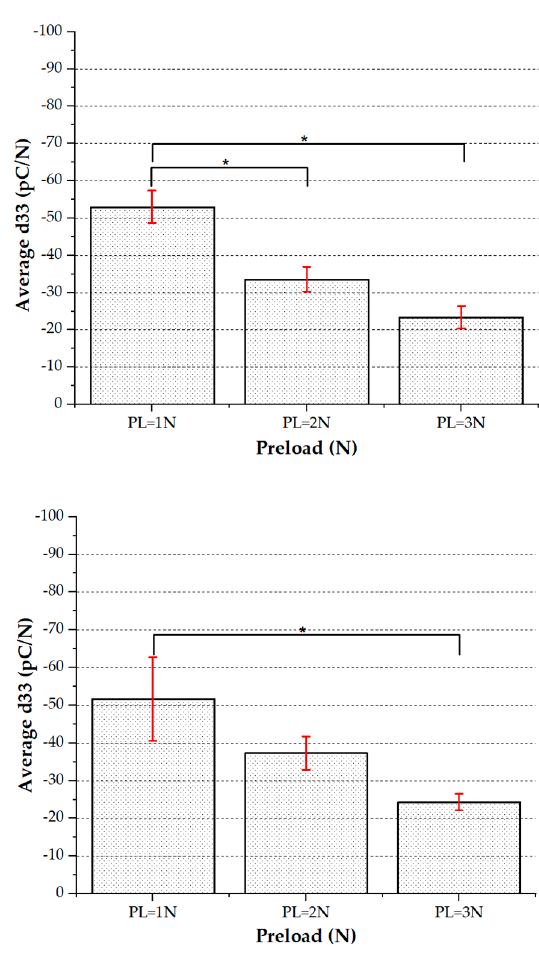
Figure 17. Average d 33 vs. preload for the three analyzed patches belonging to category 1: Palm left 2.2. ( top ), Palm left 2.3 ( middle ) and Palm left 2.4 ( bottom ).